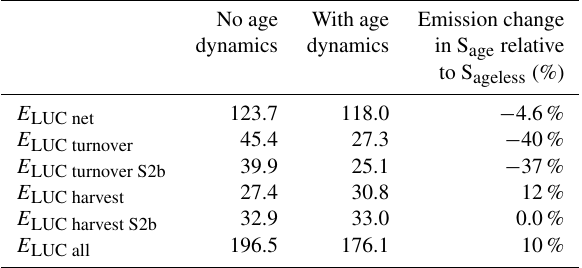
Table 3. Cumulative E LUC for 1501–2005 (PgC) from different processes quantified by different approaches (see Table 1 for de- tailed calculations of various E LUC values). No age With age Emission change